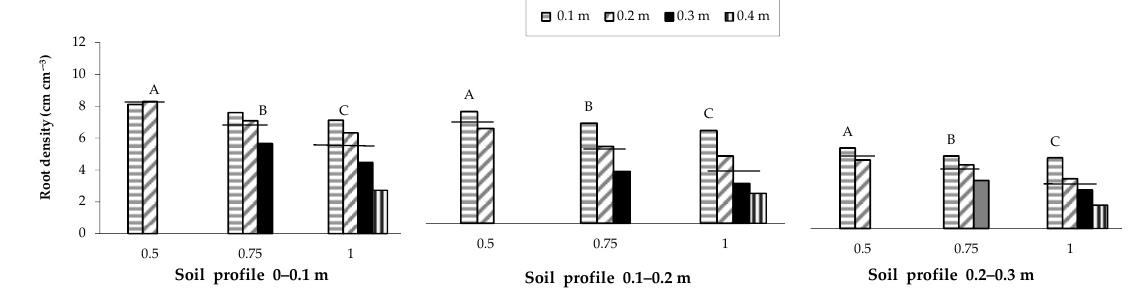
Figure 5. Root density of the maize crop as influenced by variation in row spacing (0.5, 0.75 and 1 m), soil profile (0–0.1, 0.1–0.2 and 0.2–0.3 m) and distance from the row (0.1, 0.2, 0.3 and 0.4 m). The horizontal lines over the bars represent the mean values of the groups. The group means with the same letter within each soil profile are not significantly different (SNK test at p = 0.01).